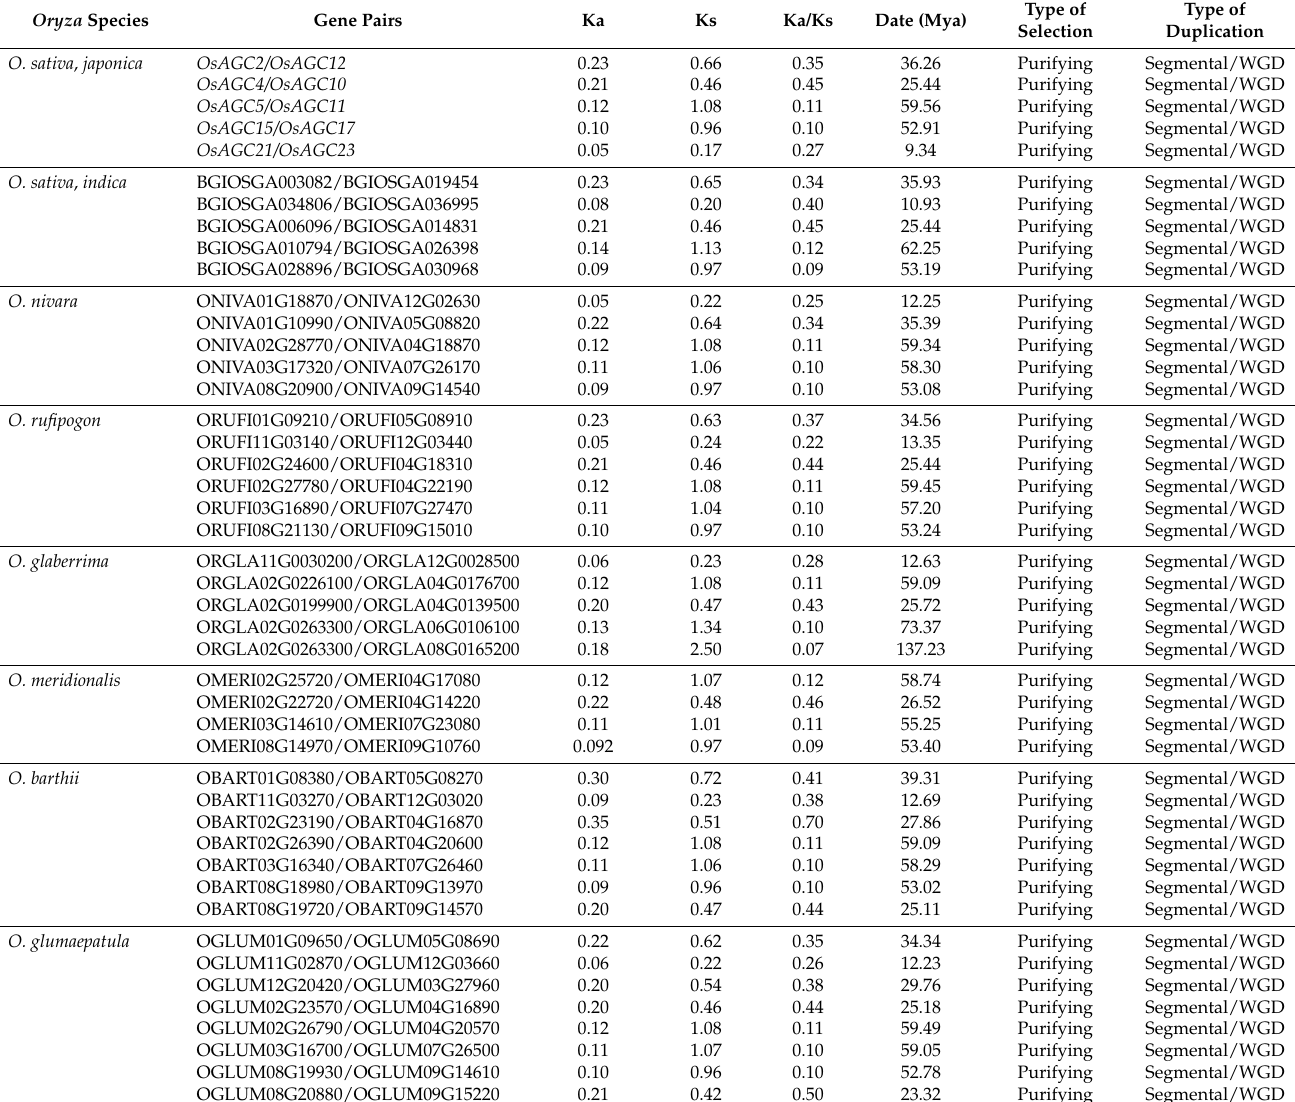
Table 2. The Ka/Ks values in duplicated gene pairs in Oryza